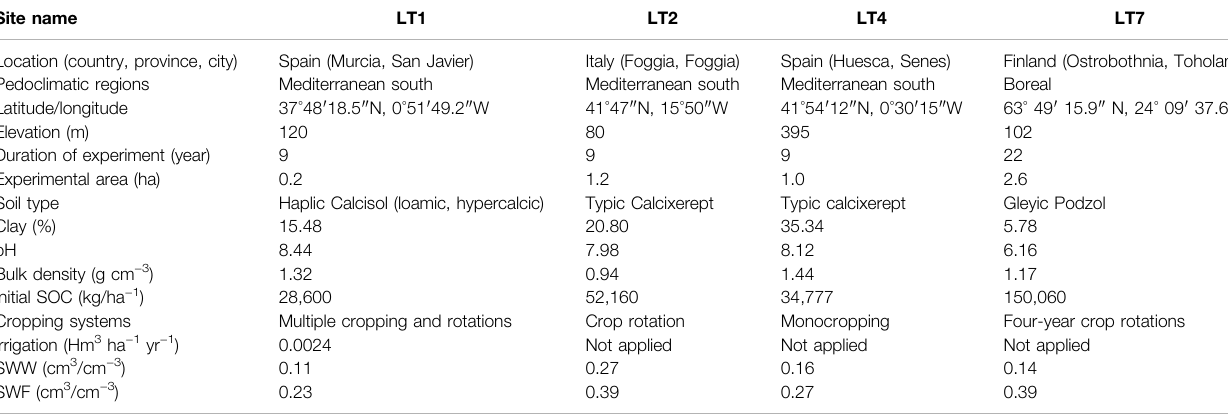
TABLE 1 | Site description, soil, and crop management in studied area for model simulations. Site